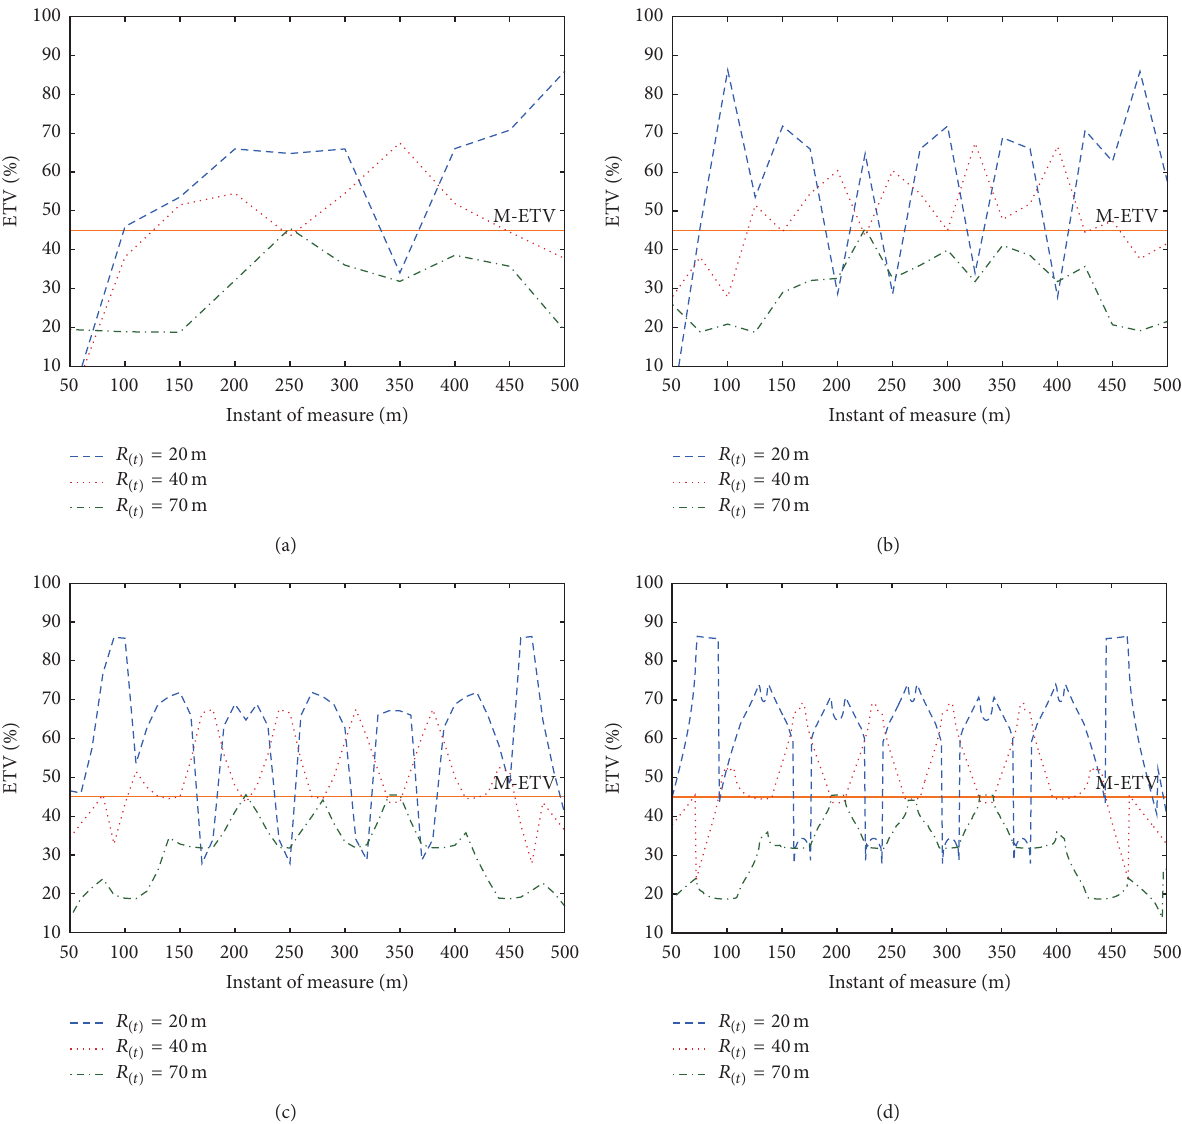
Figure13:ETVwhentargetsmovethroughthecoveredarea.(a)Targetsmove50 mforeachmeasure.(b)Targetsmove25 mforeachmeasure. (c) Targets move 10 m for each measure. (d) Targets move 1m for each measure.